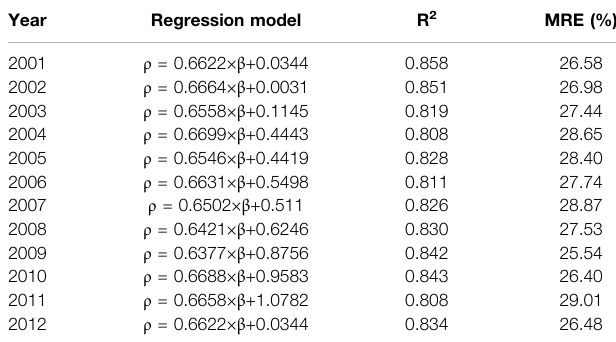
TABLE1| Populationspatialmodelfrom2001to2012( ρ and β arethepopulation density and Ln values of EAHSI, respectively). Year Regression model